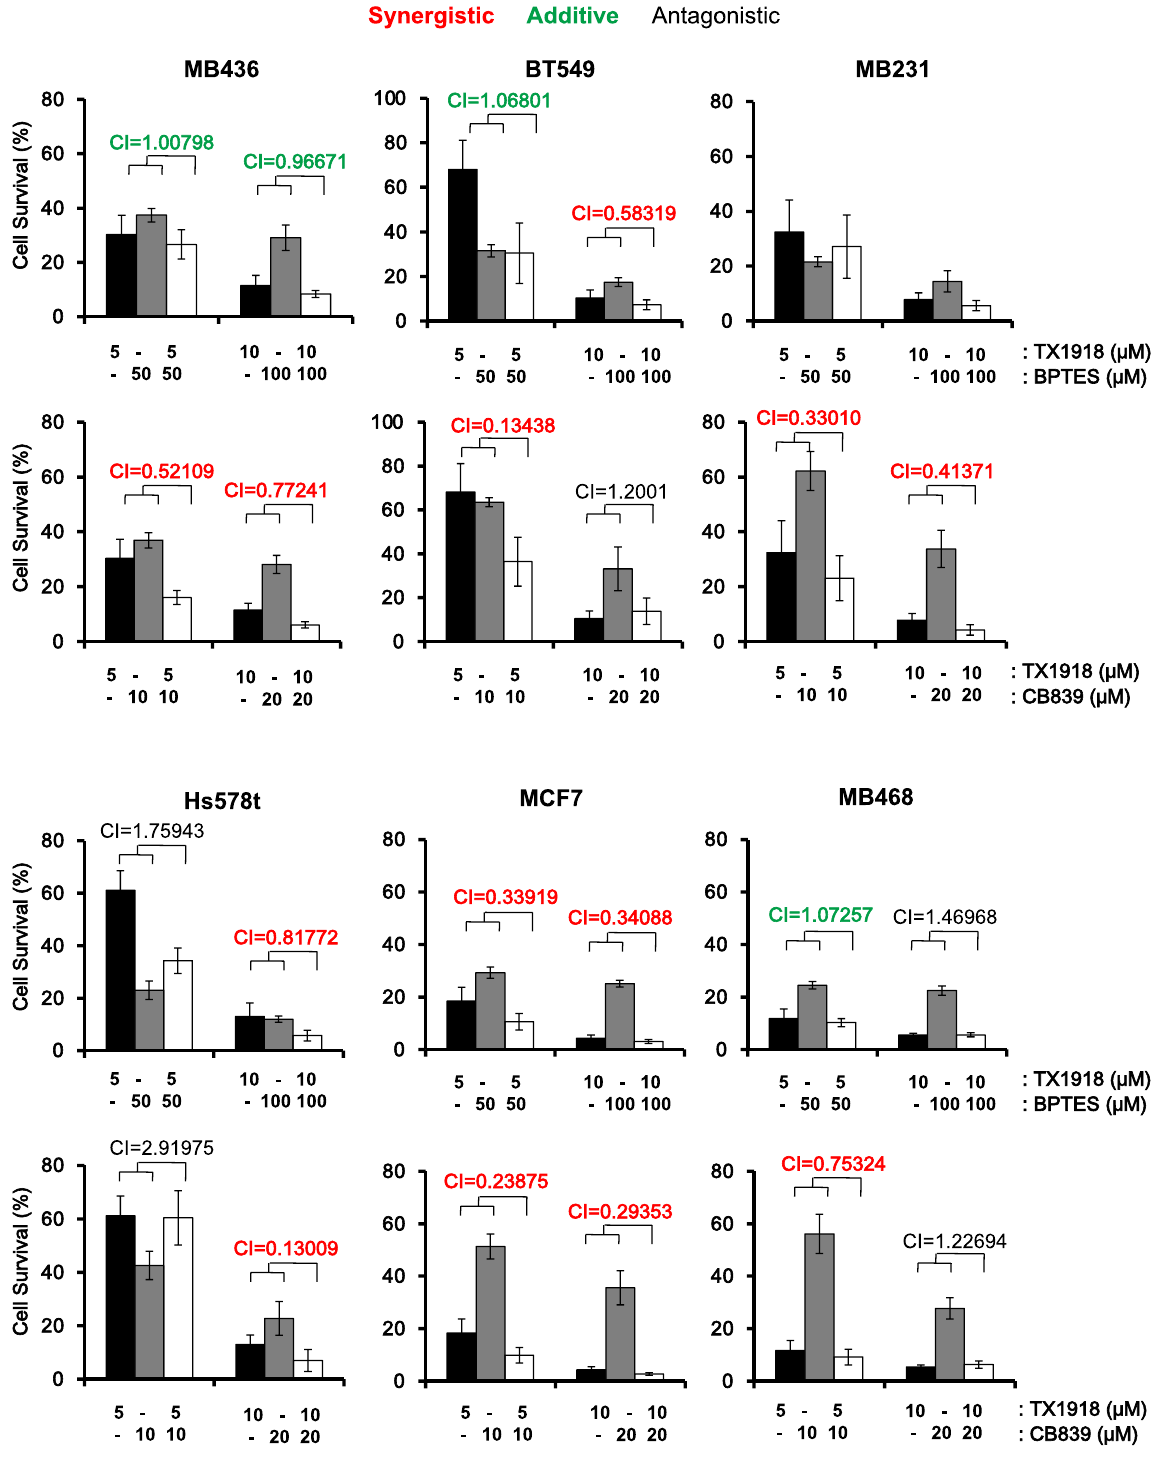
Figure 2. Synergistic inhibition of cell growth by combined treatment with the eEF2K inhibitor TX1918 plus Glutaminase 1 (GLS1) inhibitors (CB-839; BPTES). Breast cancer cells were treated with indicated concentrations of the eEF2K inhibitor TX1918, and the GLS1 inhibitors BPTES or CB-839, and effects on cell growth were determined by MTT assays. Combination Index (CI) was calculated by Compusyn software; synergistic effect (CI < 0.85; red), additive (0.85 < CI < 1.1; green), and antagonistic (CI > 1.1;